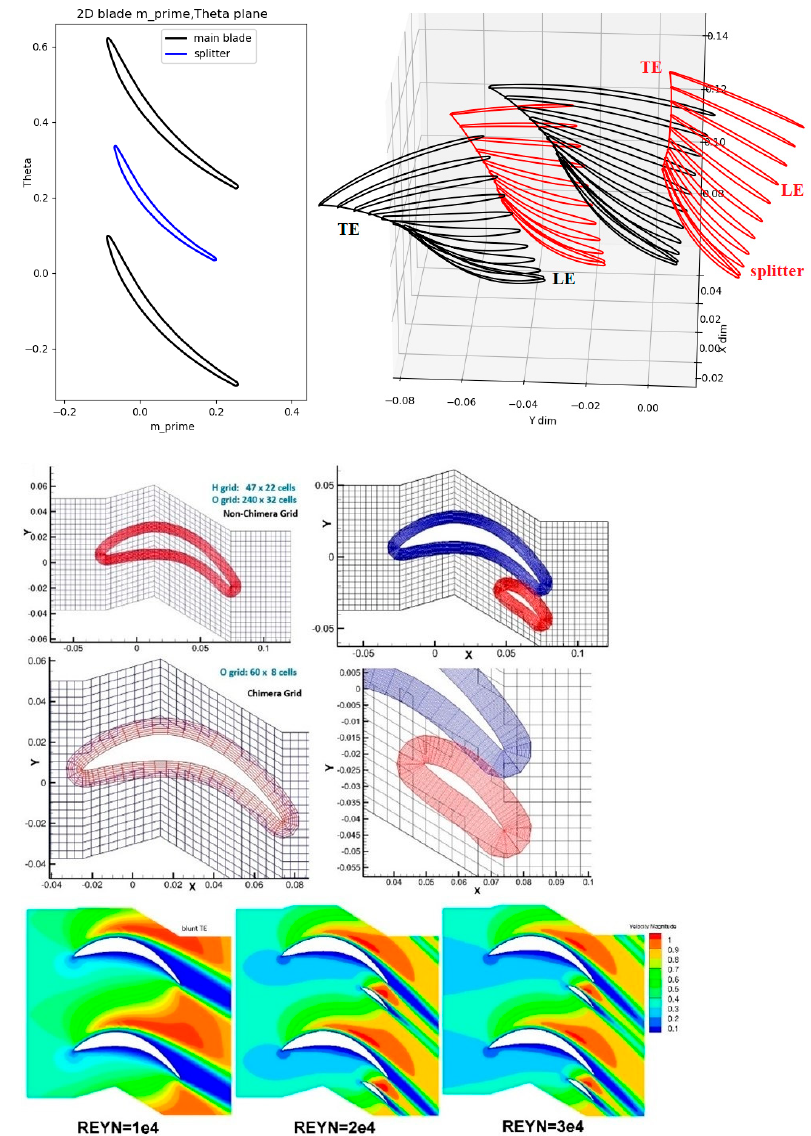
Figure 12. Blade to blade mesh at 50% span of the transonic rotor with the splitter. Chimera grid of the turbine rotor and splitter rotor solved in a higher order in ‐ house DGHB solver.